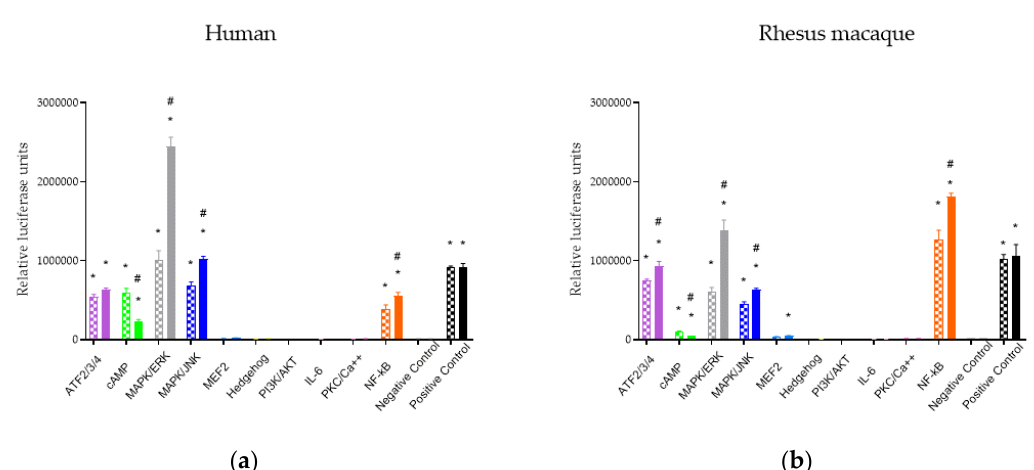
Figure 1. cAMP, NF- ĸB, MAPK/JNK , and MAPK/ERK respond to MOR activation by 10 μM DAMGO (solid bars) compared to saline (hatched bars) in both species, ( a ) human and ( b ) rhesus macaque. * indicates p < 0.05 compared to the negative control, # indicates p < 0.05 in the DAMGO group compared to saline.